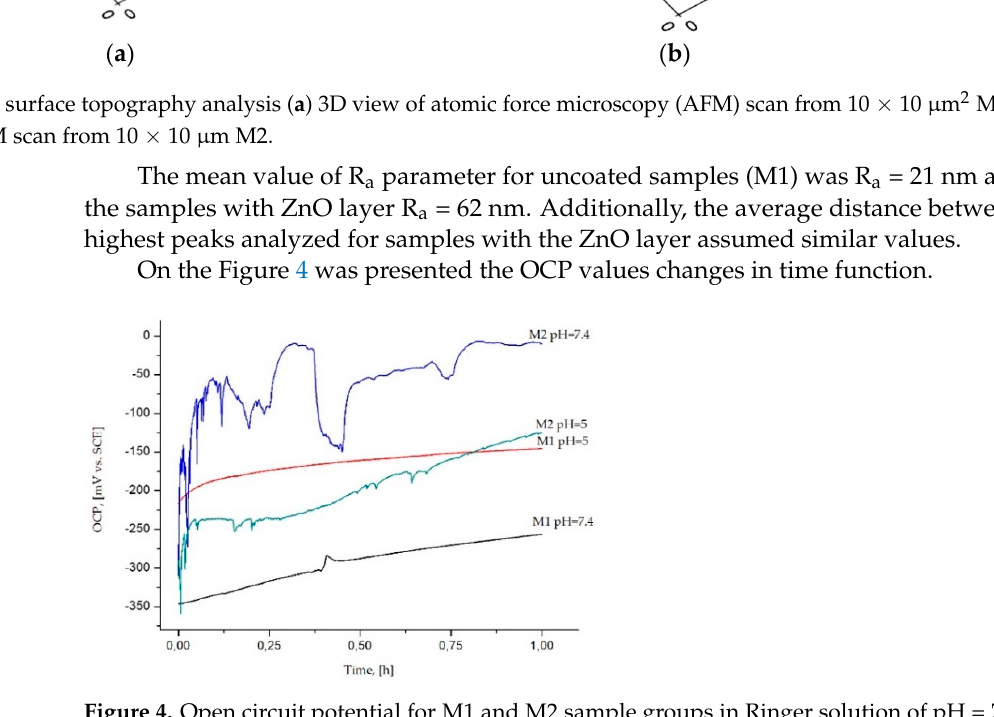
Figure 4. Open circuit potential for M1 and M2 sample groups in Ringer solution of pH = 7.4 and pH = 5, exposure for t = 1h.